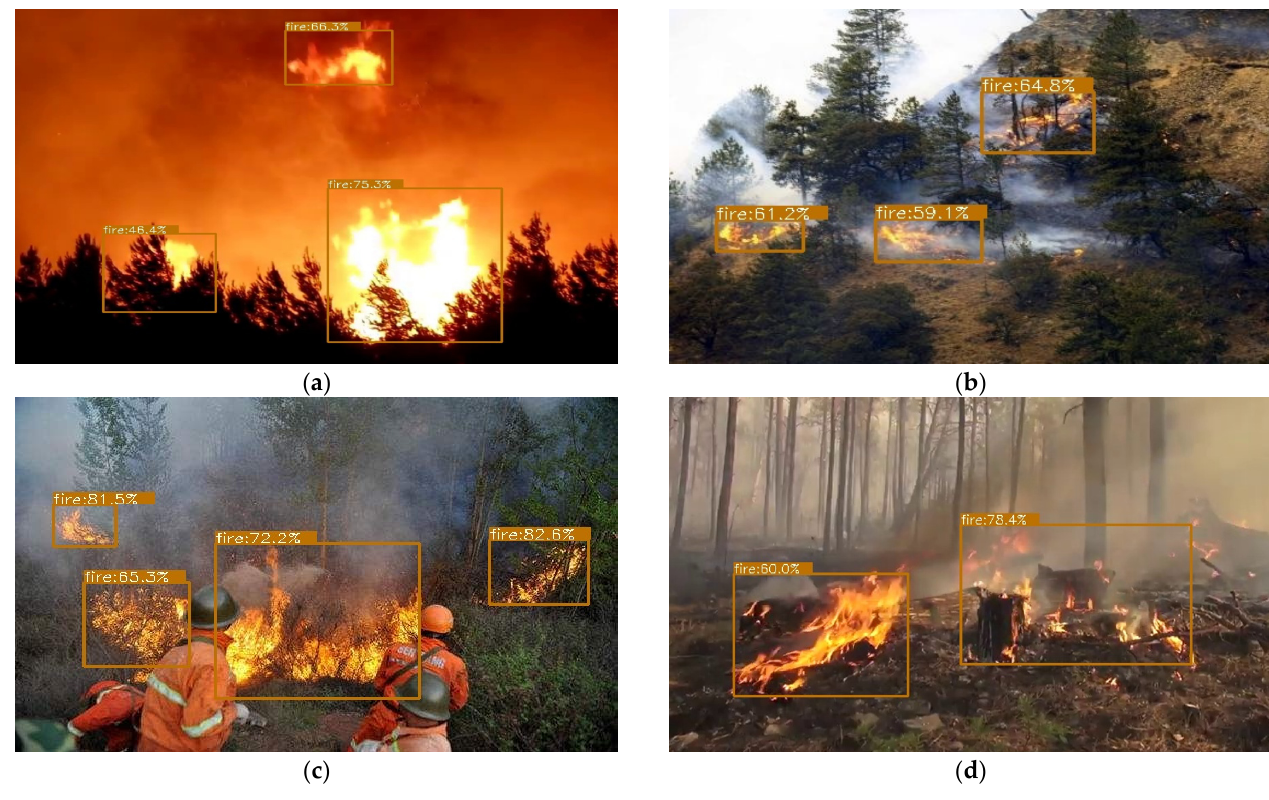
Figure 12. The detection results on our test dataset. ( a ) The dark night scene; ( b ) the mountainside scene; ( c ) the shrubs scene; and ( d ) the ground-fire scene.